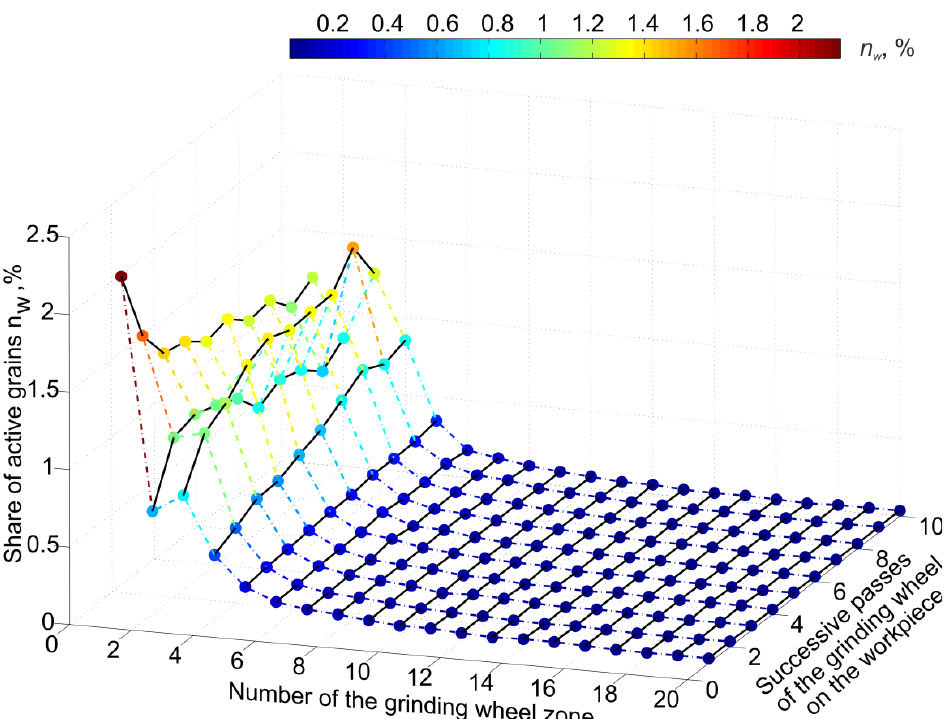
Figure 6. Share of active grains in the total number of grains on the grinding wheel surface depending on the zone numbers .